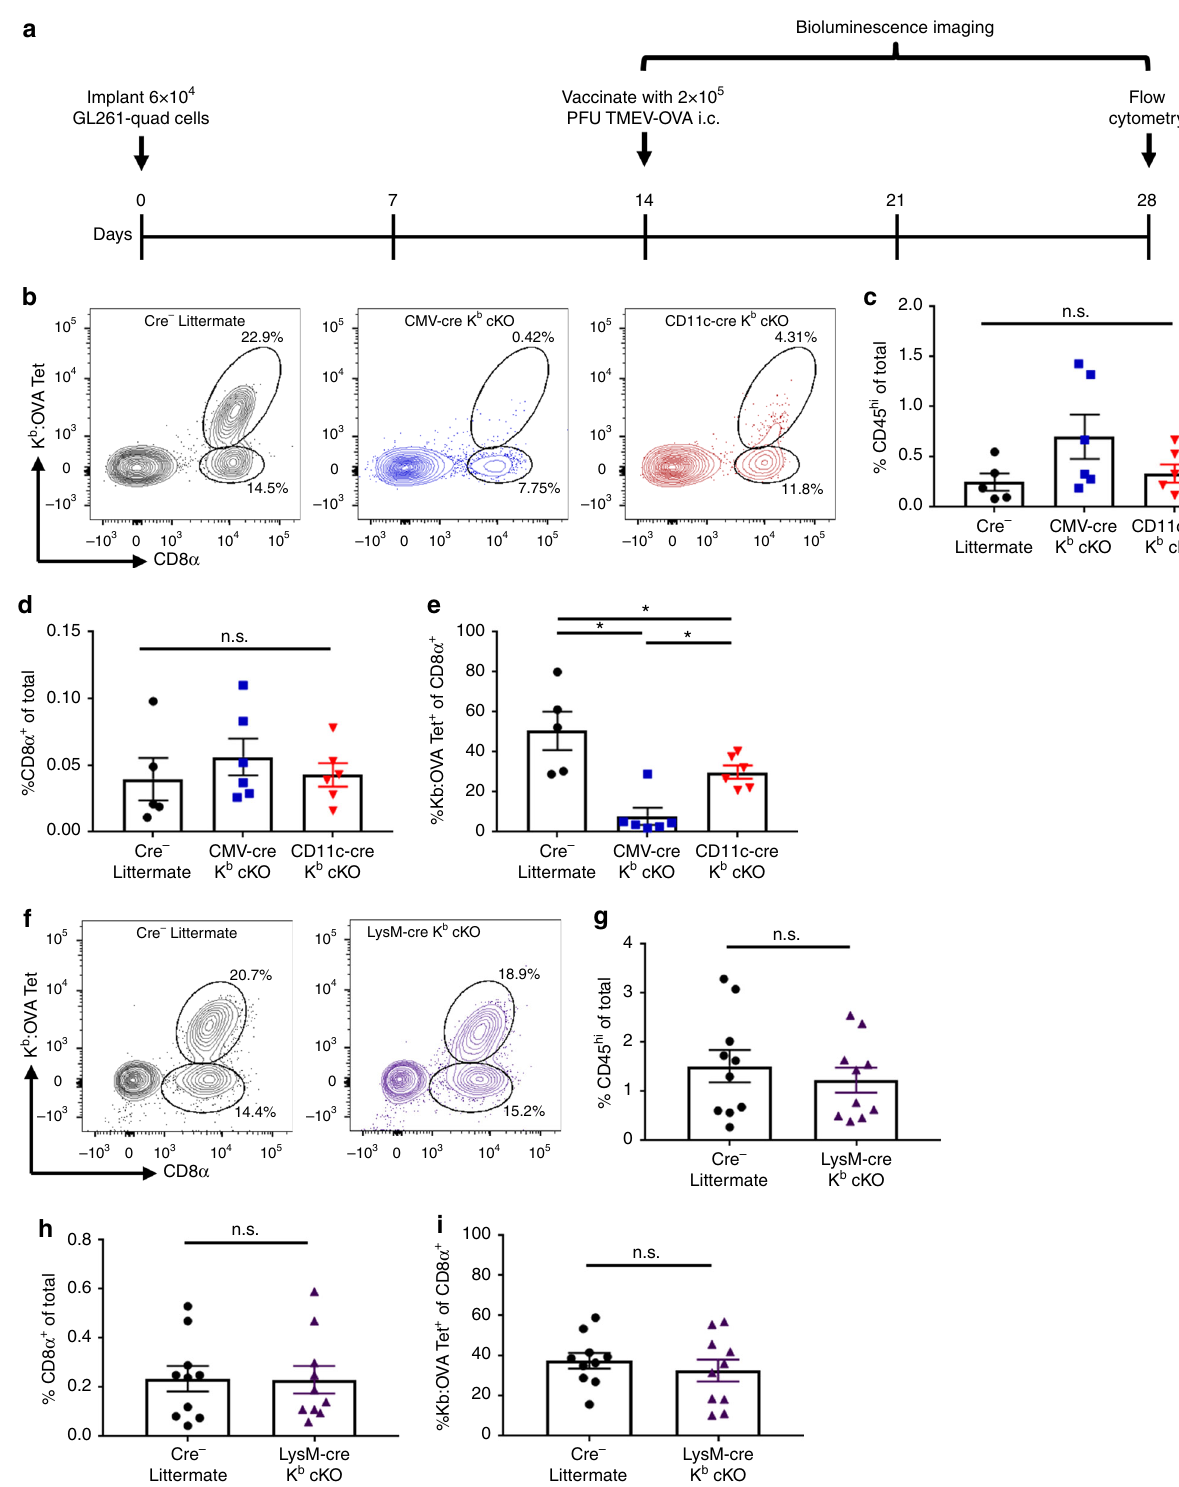
Fig. 7 Dendritic cell-speci fi c deletion of K b disrupts CD8 + T-cell priming against gliomas. a Timeline of GL261-quad cassette tumor inoculation, bioluminescence imaging, and vaccination. b Representative fl ow cytometry plots. There was no difference in CD45 hi cell ( c ) or CD8 + T-cell ( d ) in fi ltration into the CNS of GL261-bearing animals. e Quanti fi cation demonstrate that CD11c-cre K b cKO animals lose the ability to respond to GL261-gliomas following vaccination, though not as severely as CMV-cre K b cKO animals ( N = 5, 6, 6 per group, respectively). f Representative plots and g − i quanti fi cation demonstrate that LysM-cre K b cKO animals respond to GL261-quad cassette gliomas similarly to controls ( N = 10 per group). Data presented as mean with error bars representing standard error of the mean (SEM). * denotes p < 0.05 by Mann − Whitney U Test or one-way ANOVA with Holm − Sidak